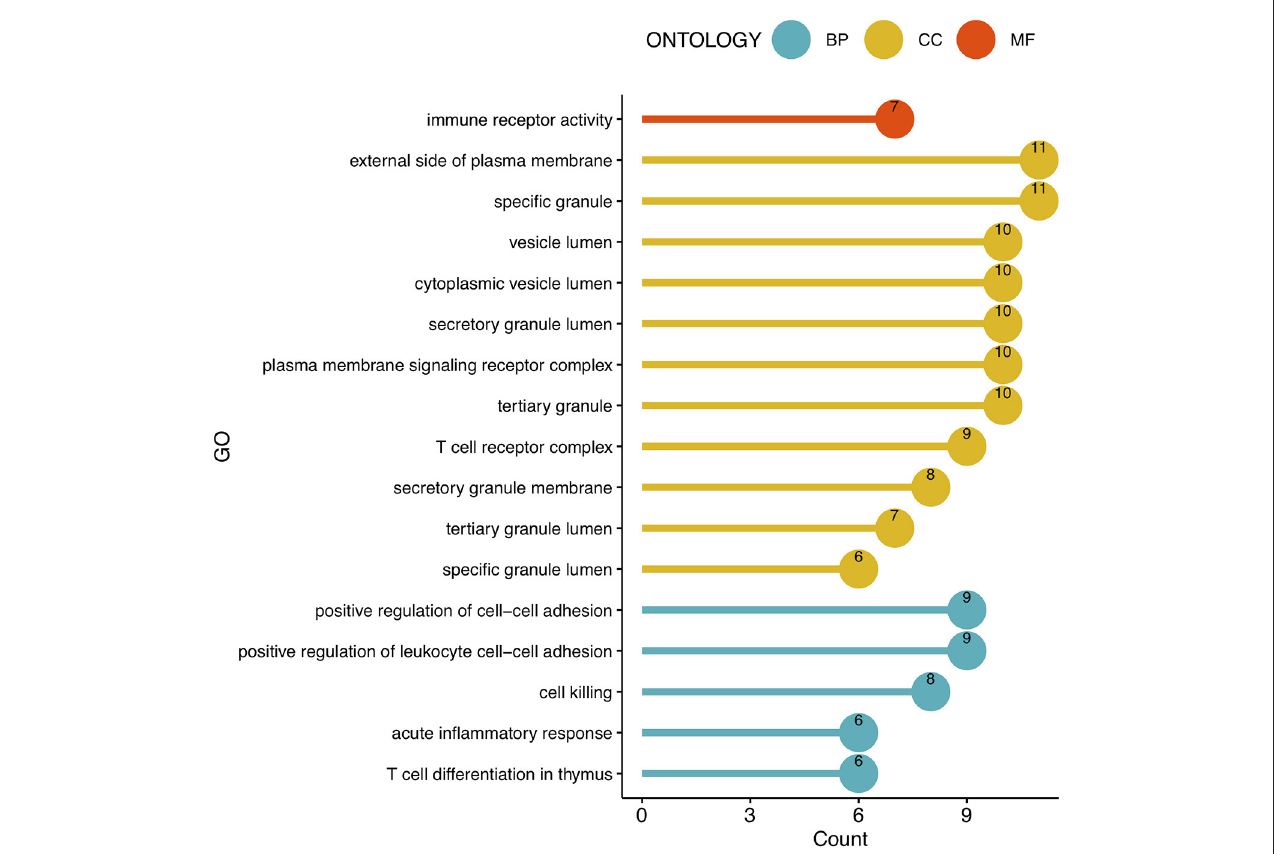
FIGURE4 Bubble diagram of GO enrichment functions. Green, yellow, and red dots represent counts. GO, Gene Ontology; BP, Biological Process; CC, Cell Component; MF, Molecular Function.